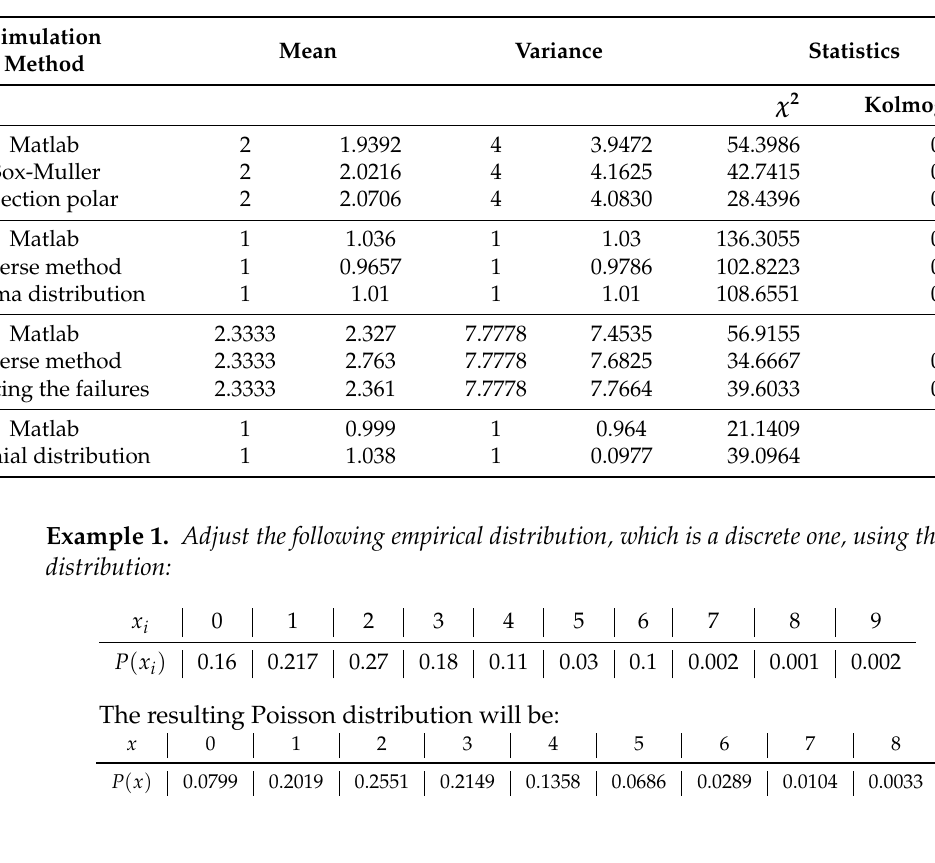
Figure 1. The histograms built for X ∼ Geom ( p ) , using three methods. The statistics associated to the concordance tests are also computed in the Table 1. Table 1. The methods used to generate a selection of volume 1000 on the random variable X , having some continuous and discrete